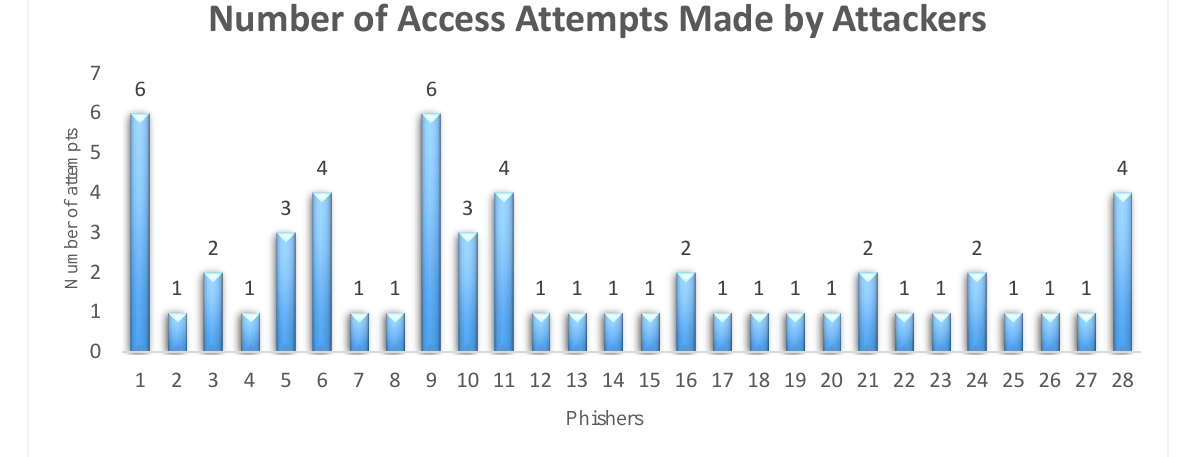
Figure 11. Number of attempts made by attackers to gain access to the system .